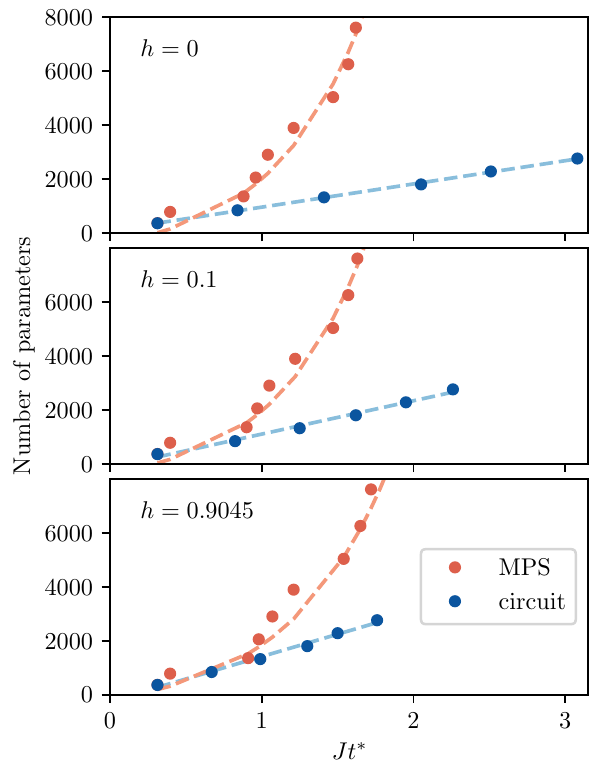
FIG. 3. Comparison of the number of parameters and the accessible time t ∗ . This time t ∗ corresponds to the time at which the fidelity F drops below 1 − 10 − 4 . Data shown for MPS and our quantum circuit ansatz for three values of the longitudinal field h . The dashed lines correspond to exponential (MPS) and linear (circuit) fits, respectively. See Appendix F for more